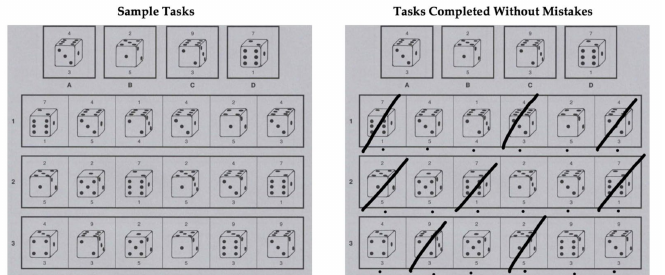
Figure 1. Sample tasks sustained attention test (copyright Beltz Test GmbH, Göttingen—Reprinting and any kind of reproduction